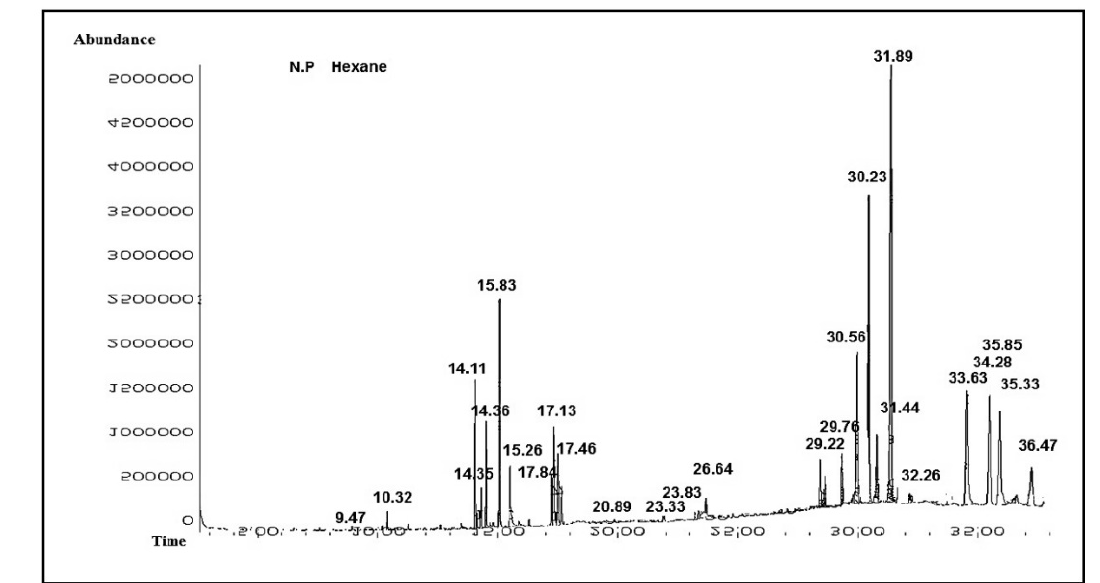
Figure 2. GC ‐ MS chromatogram of Neurada procumbens n ‐ hexane fraction. Figure 2. GC-MS chromatogram of Neurada procumbens n -hexane